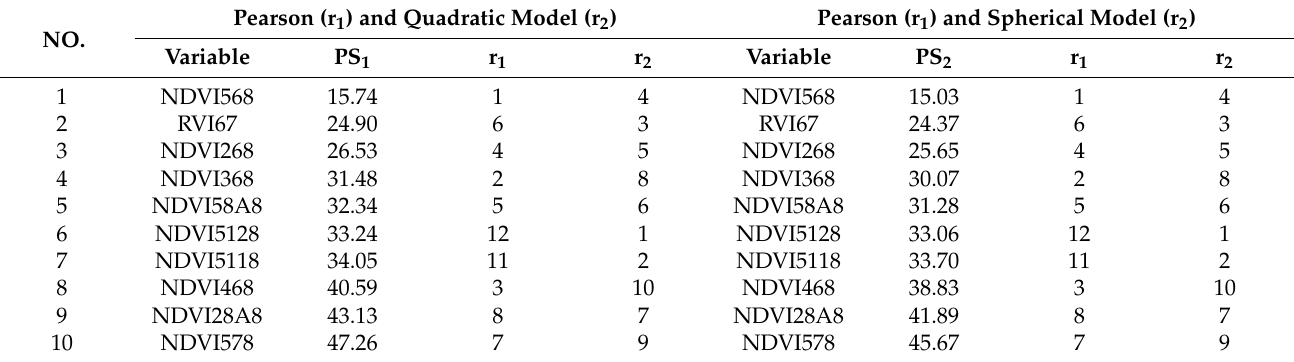
Table 5. PS values of the top 10 variables extracted from Sentinel-2